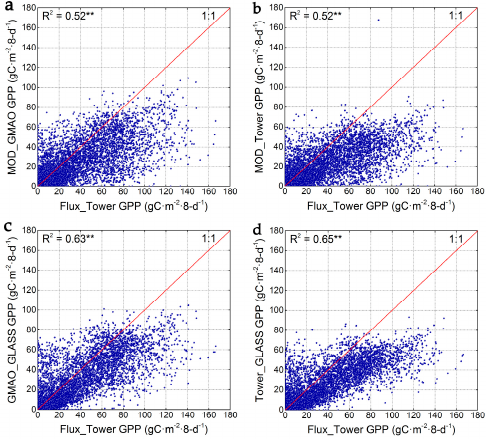
Figure 1. Scatter plots of the eight-day MOD_GMAO GPP vs. the Flux_Tower GPP ( a ), MOD_Tower GPP vs. the Flux_Tower GPP ( b ), GMAO_GLASS GPP vs. the Flux_Tower GPP ( c ) and Tower_GLASS GPP vs. the Flux_Tower GPP ( d ). Significance levels: ** p < 0.01. GMAO, Global Modeling and Assimilation